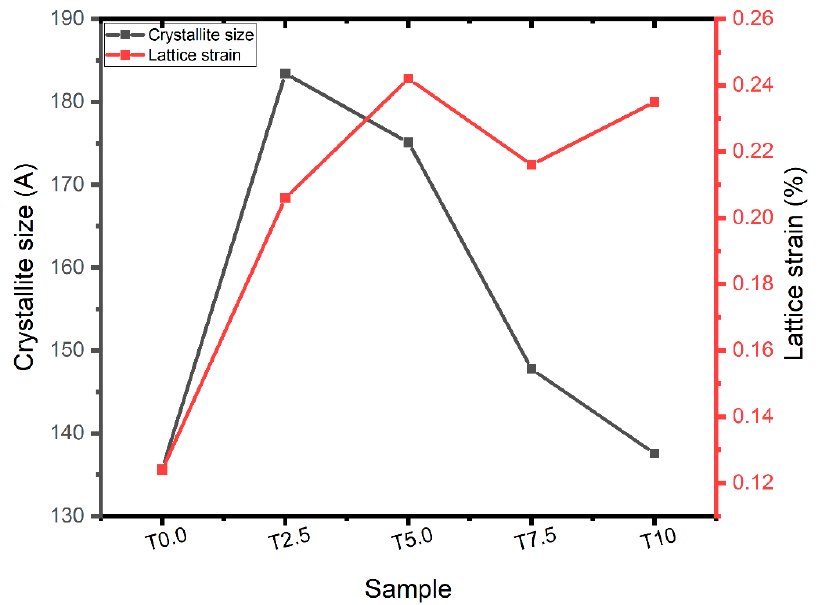
2 –Ti composites.